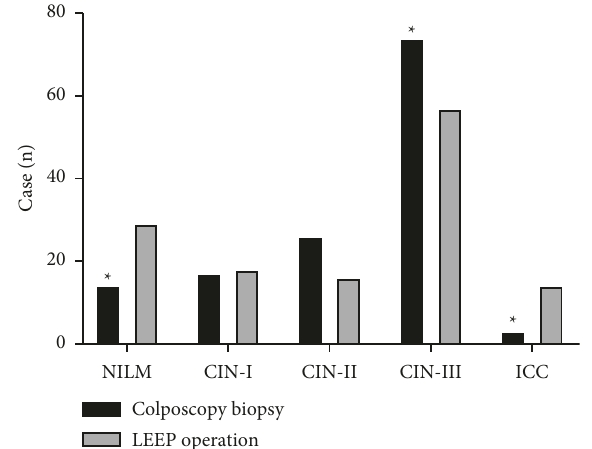
Figure 1: Comparison of pathological examination results after colposcopic biopsy and LEEP